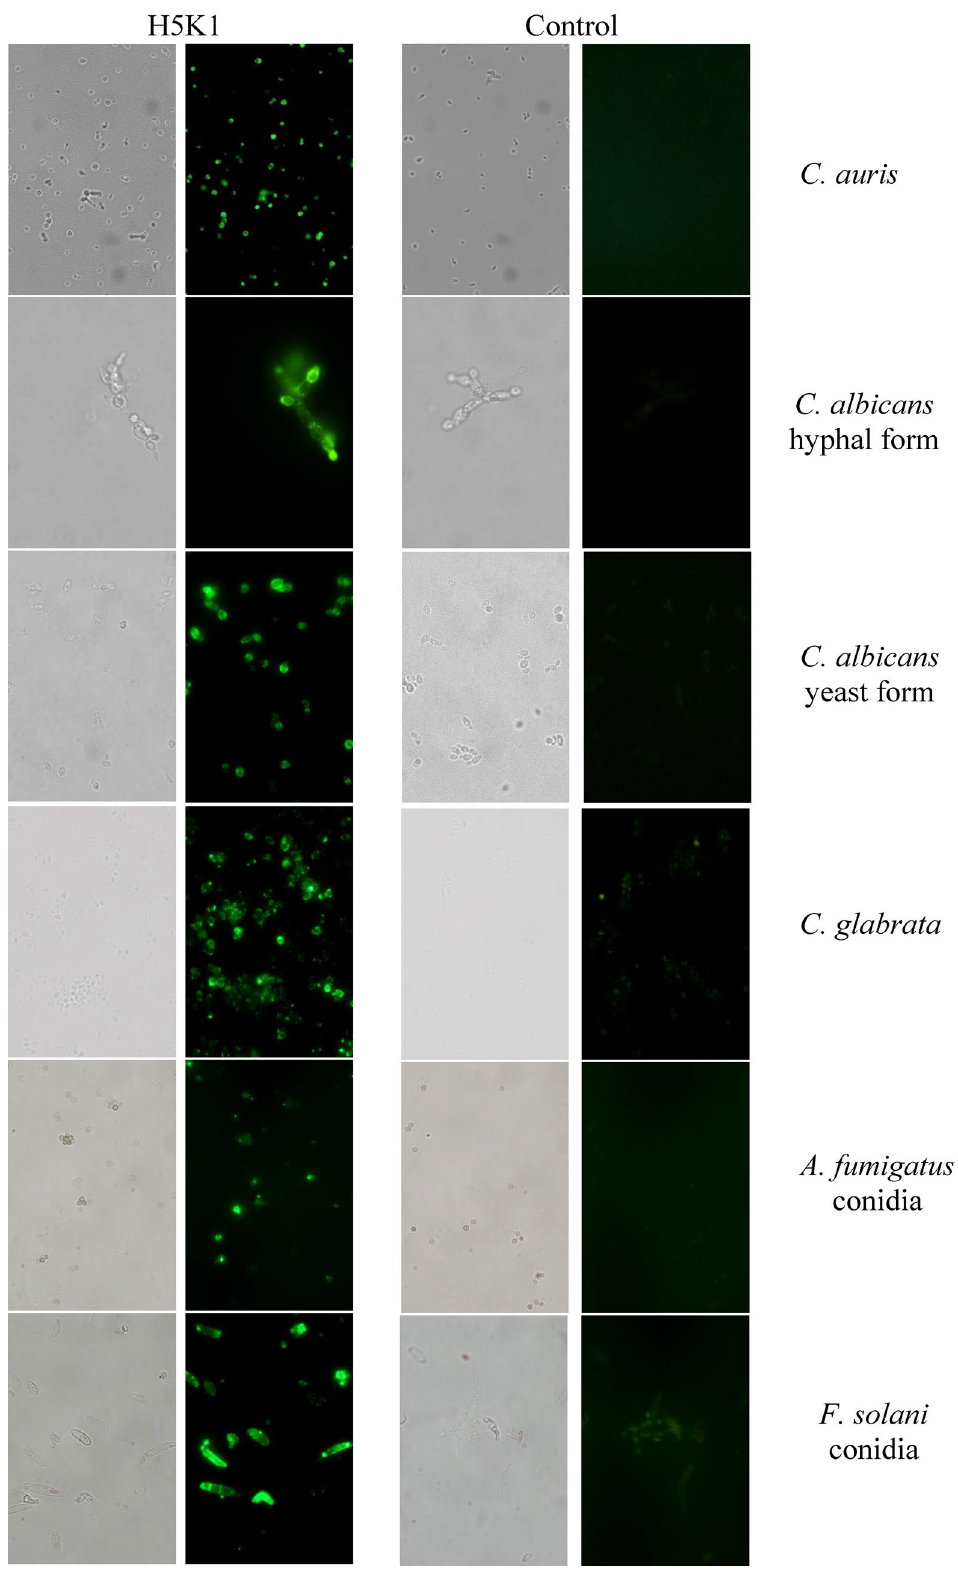
Figure 6. Binding analysis by means of immunofluorescence technique. Green fluorescence and bright-field